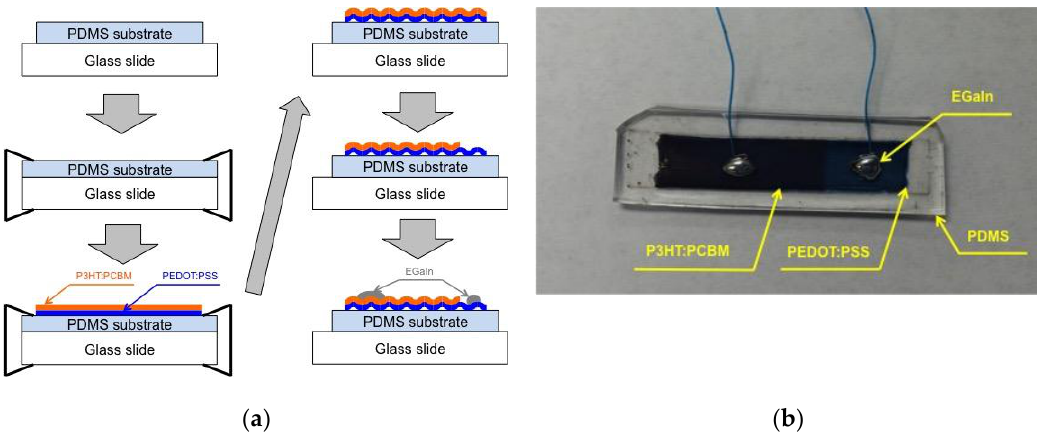
Figure 1. ( a ) A flexible strain sensor is fabricated by depositing corrugated P3HT:PCBM and PEDOT:PSS thin films on a pre-strained PDMS substrate. ( b ) The fabricated flexible strain sensor